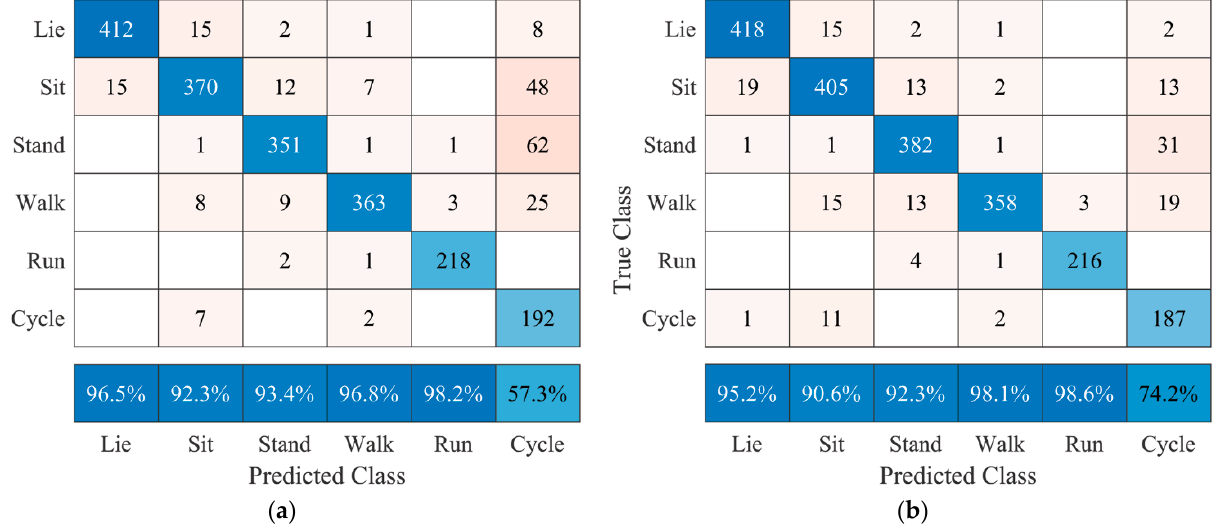
Table 7. Classification results for different sensor combinations when assessing model performance using varying transmitter sensor placements after training the model based on the data of sensors 3,4, and 5. Shown are mean accuracies (%) and the corresponding standard deviation of all seven subjects when developing user-specific or generalized models.